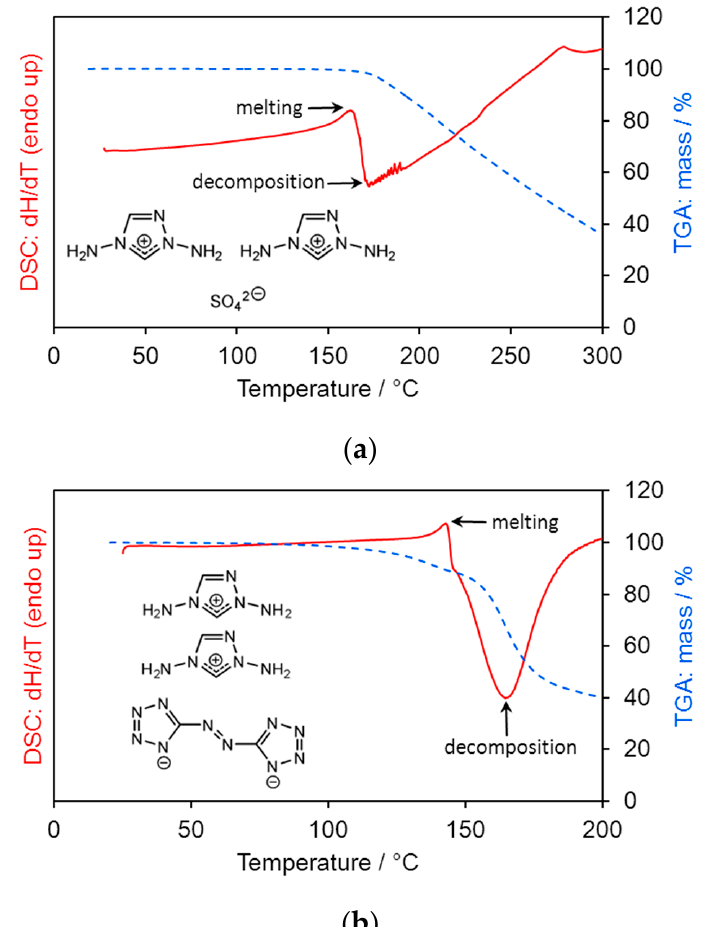
Figure 4. DSC and TGA of ( a ) bis(1,4-diamino-1,2,4-triazolium) sulfate ( 1 ) and ( b ) 5,5'-azotetrazolate ( 2 ). Heating rate 10 °C·min − 1 .